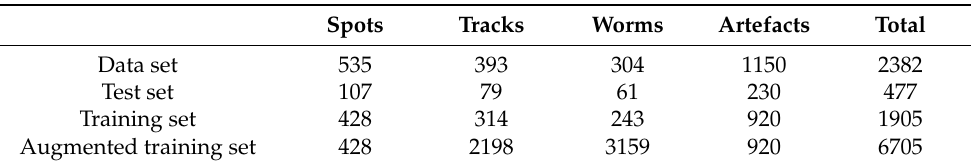
Table 4. Statistics describing the partitioning and augmentation scheme of the dataset used in the second phase of computation (Figure 10).